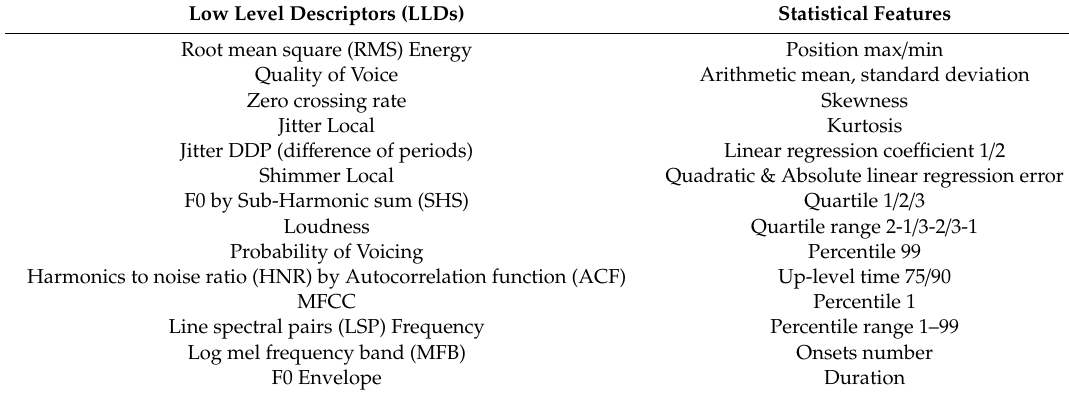
Table 8. Acoustic features used in the literature